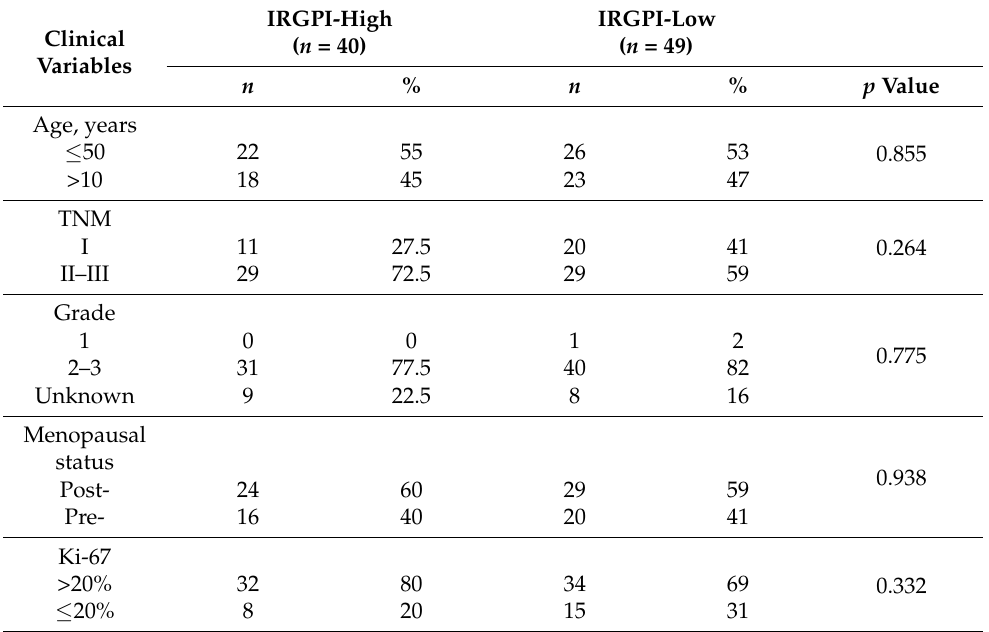
Table 1. Relationship between IRGPI and the clinicopathological characteristics of TNBC patients from our